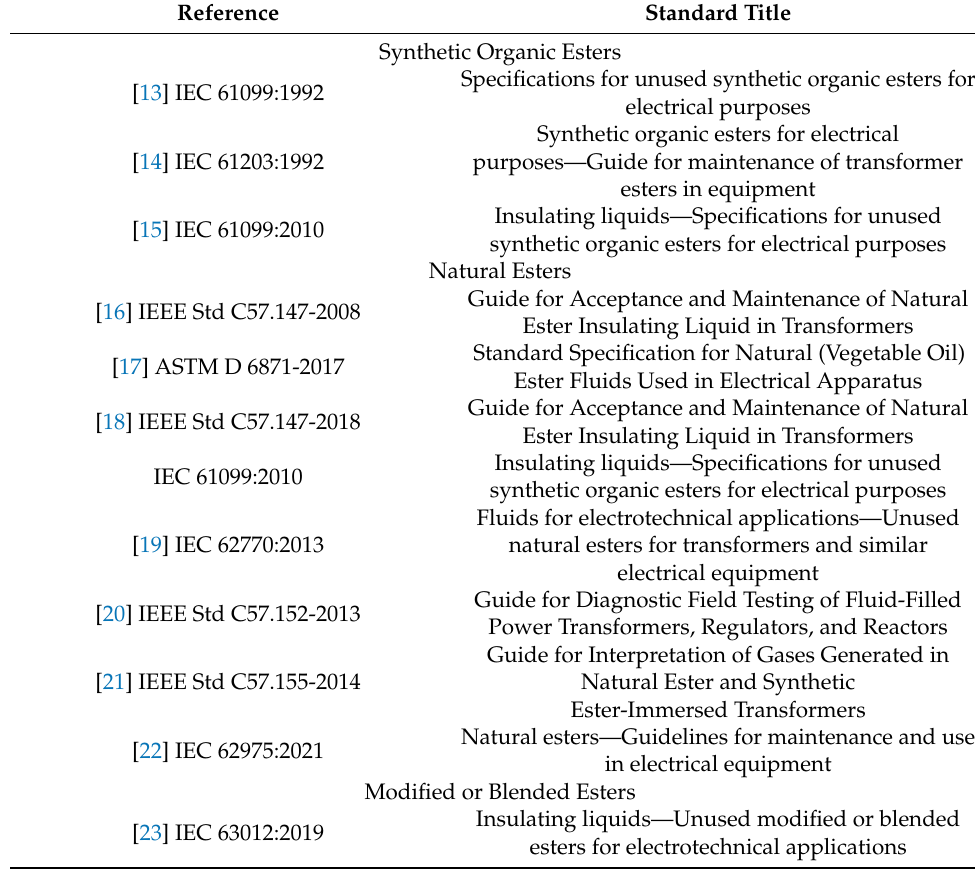
Table 2. Evolution of standardization on ester-type